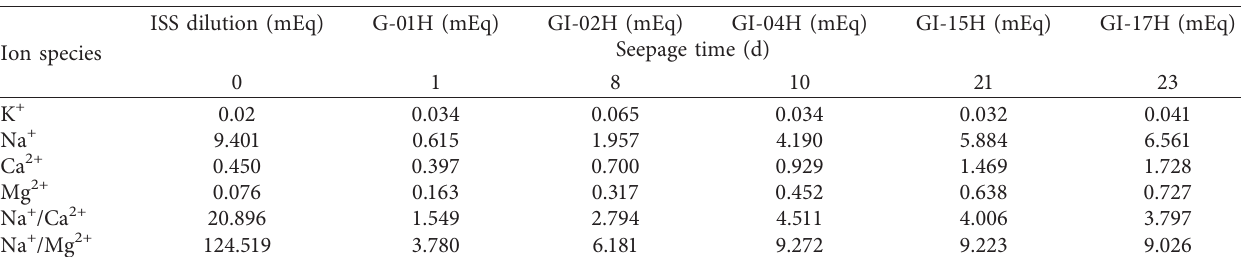
Figure 3: The concentration variation of main cations from the exudate in different periods. Table 10: Milligram equivalent of the main cations from the exudate in different